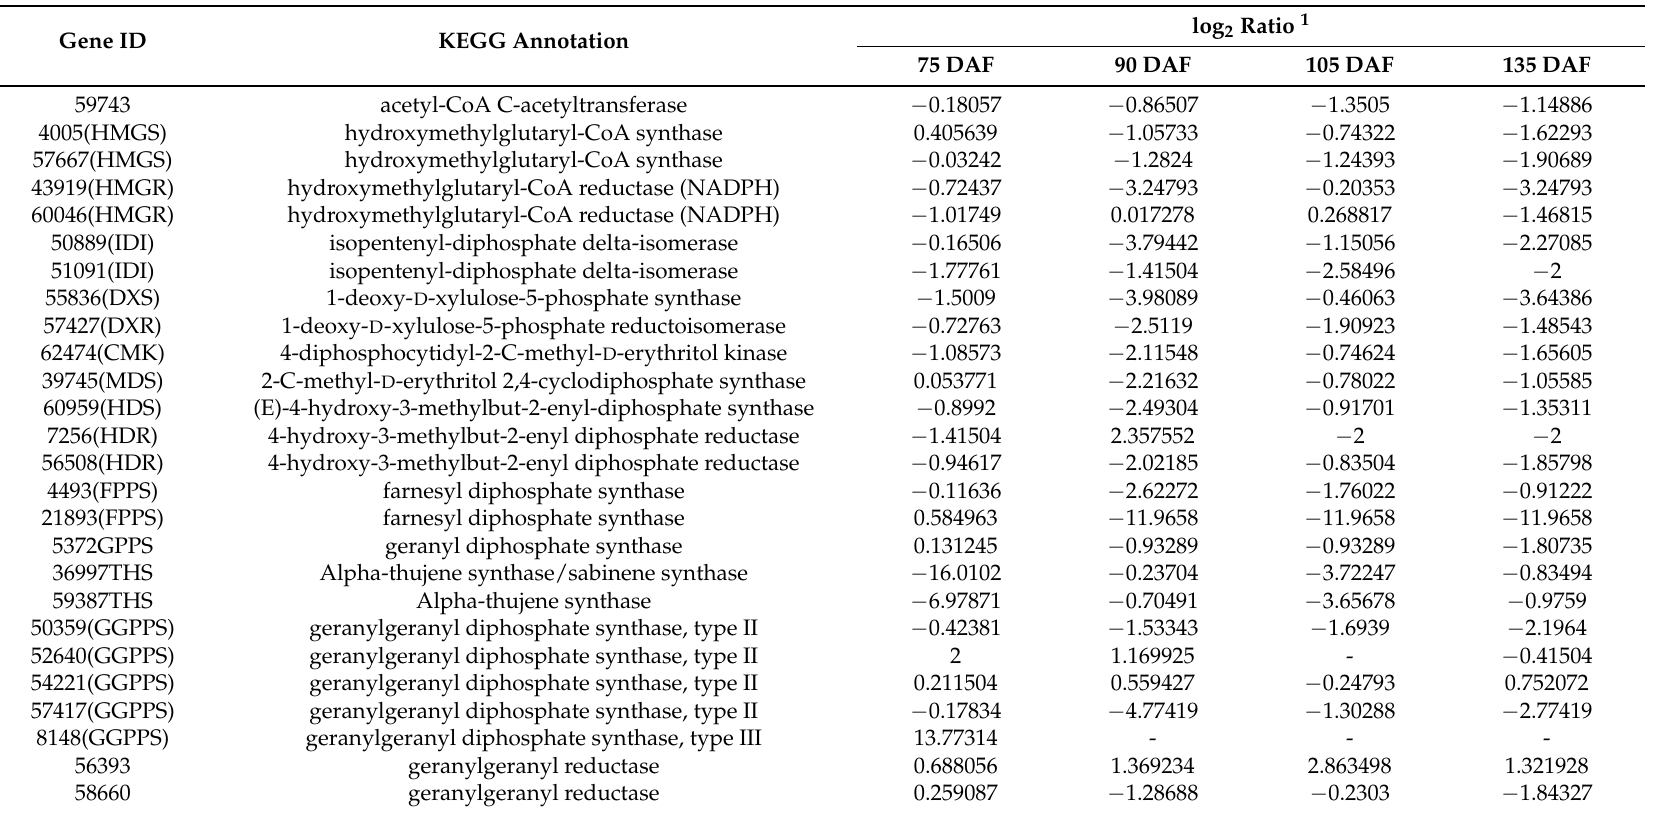
Table 2. DEGs associated with the terpenoid backbone biosynthesis